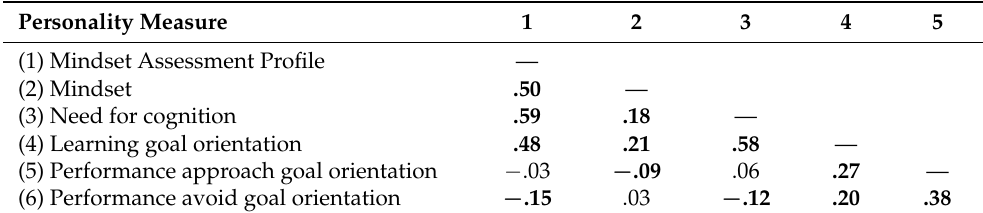
Table 2. Correlation